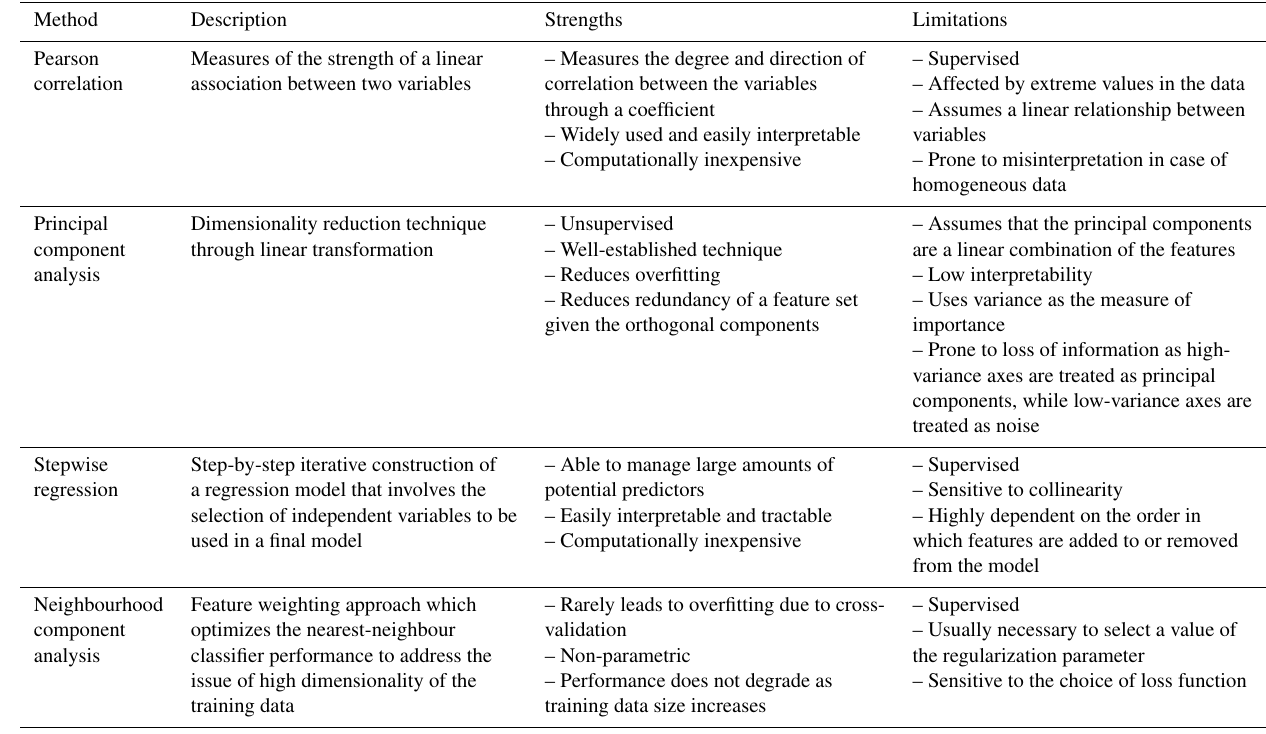
Table 2. Comparison of strengths and limitations of methods